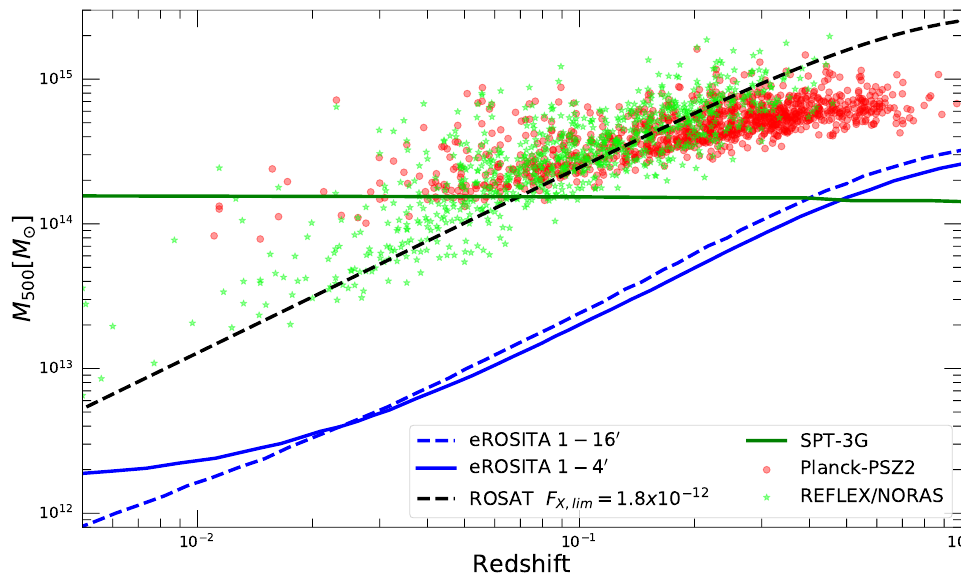
Figure 19. Expected sensitivity curve of the final eROSITA survey (eRASS:8) compared to the sensitivity of existing and upcoming X-ray and SZ surveys. The eROSITA sensitivity curve was computed from synthetic data using a wavelet decomposition algorithm [343] sensitive to scales of 1–4 (cid:48) (solid blue curve) and 1–16 (cid:48) (dashed blue curve). For comparison, the dashed black curve shows the sensitivity of the ROSAT all-sky survey assuming a fixed soft X-ray flux threshold of 1.8 × 10 − 12 erg s − 1 , which is the typical sensitivity of the REFLEX and NORAS samples (green asterisks, [345]). The red points show the systems selected from the second Planck SZ catalogue [346]. The green curve shows the expected sensitivity of the SPT-3G experiment